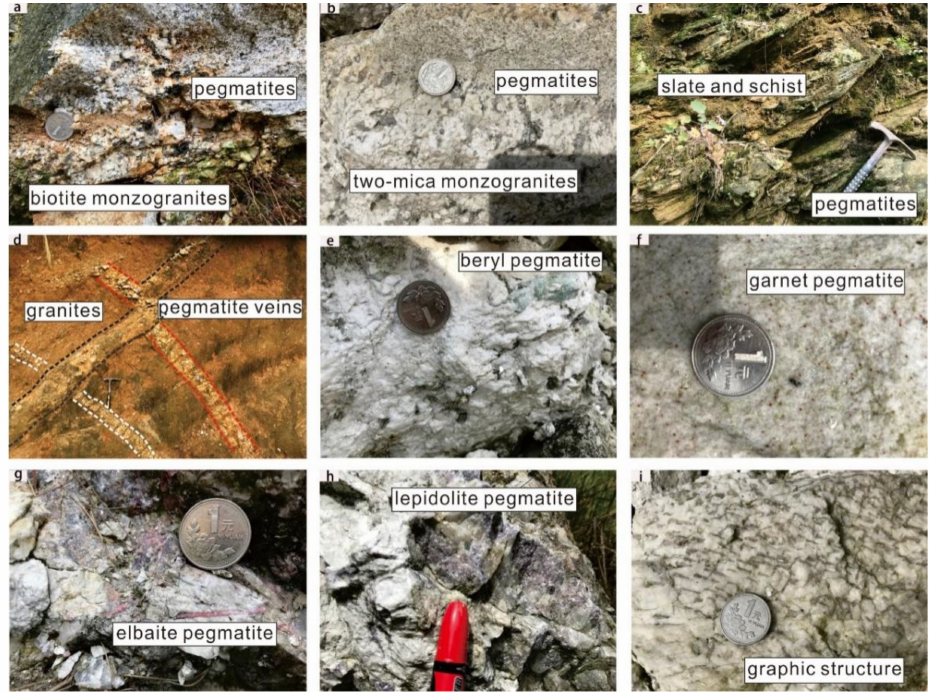
Figure 3. Field photographs showing features of granites and pegmatites in the Renli Nb-Ta deposit: ( a ) biotite monzogranites with porphyritic structure; ( b ) weakly gneissic two-mica monzogranites; ( c ) pegmatite contact with schist of the Lengjiaxi group; ( d ) three pegmatite veinlets with various compositions interspersed in the granite; ( e – h ) beryl pegmatite, garnet pegmatite, elbaite